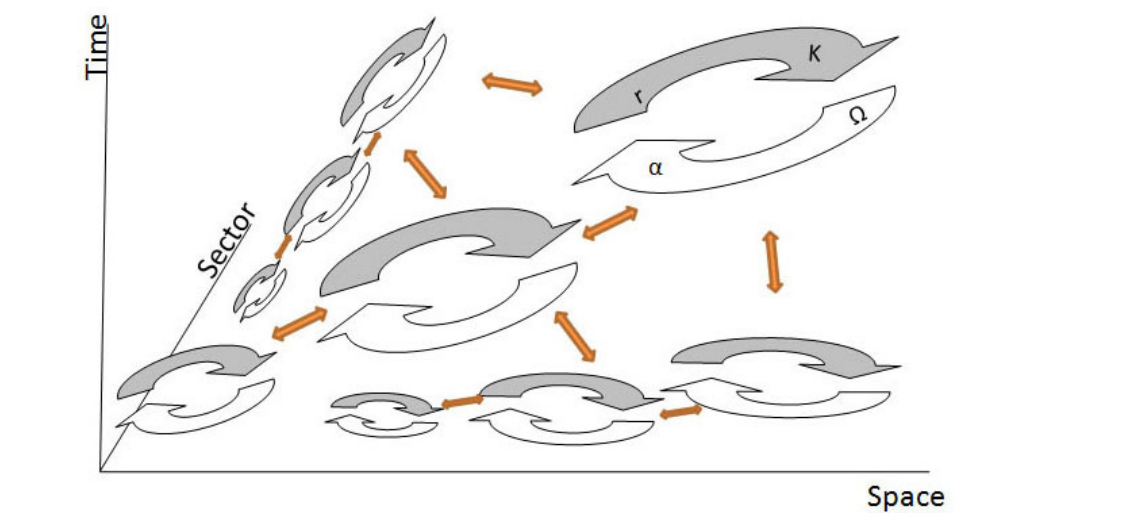
Fig. 5 . A schematic illustration of interlocking panarchies. Each set of linked adaptive cycles form a panarchy, representative of forestry, environmental conservation, and reindeer husbandry respectively. Processes in an adaptive cycle at a certain scale may affect both other adaptive cycles in the same panarchy, and adaptive cycles in other panarchies, creating a system with numerous interactions at many scales. See text for further details and